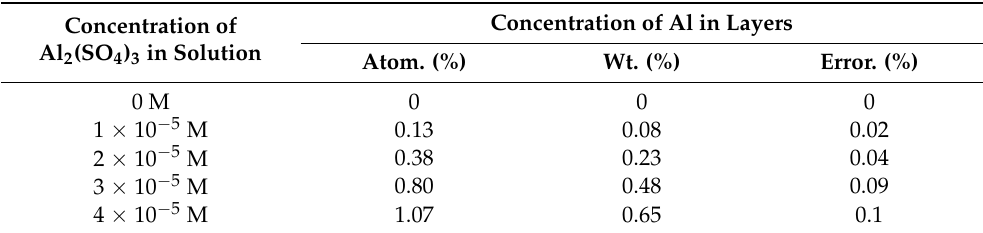
Table 2. EDX analysis for Al concentrations in electrochemically deposited ZnO layers with different concentrations of Al 2 (SO 4 ) 3 .